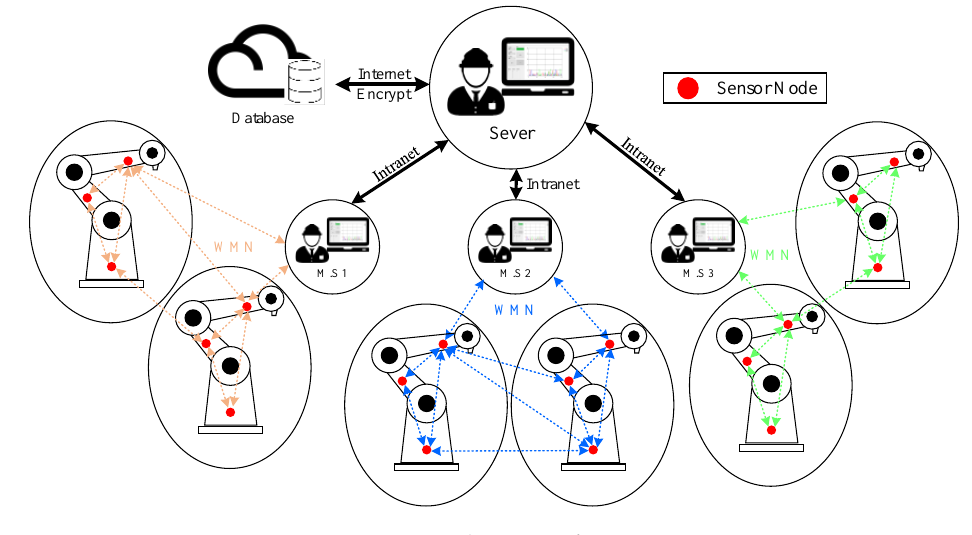
Figure 7. Architecture of WMN.